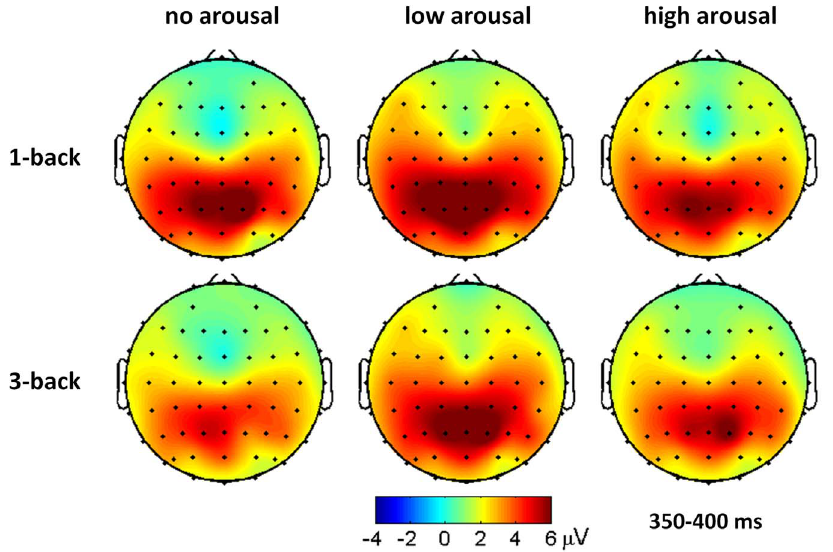
Figure 4. Grand average ERP topographies of the parietal P3 components across different conditions.